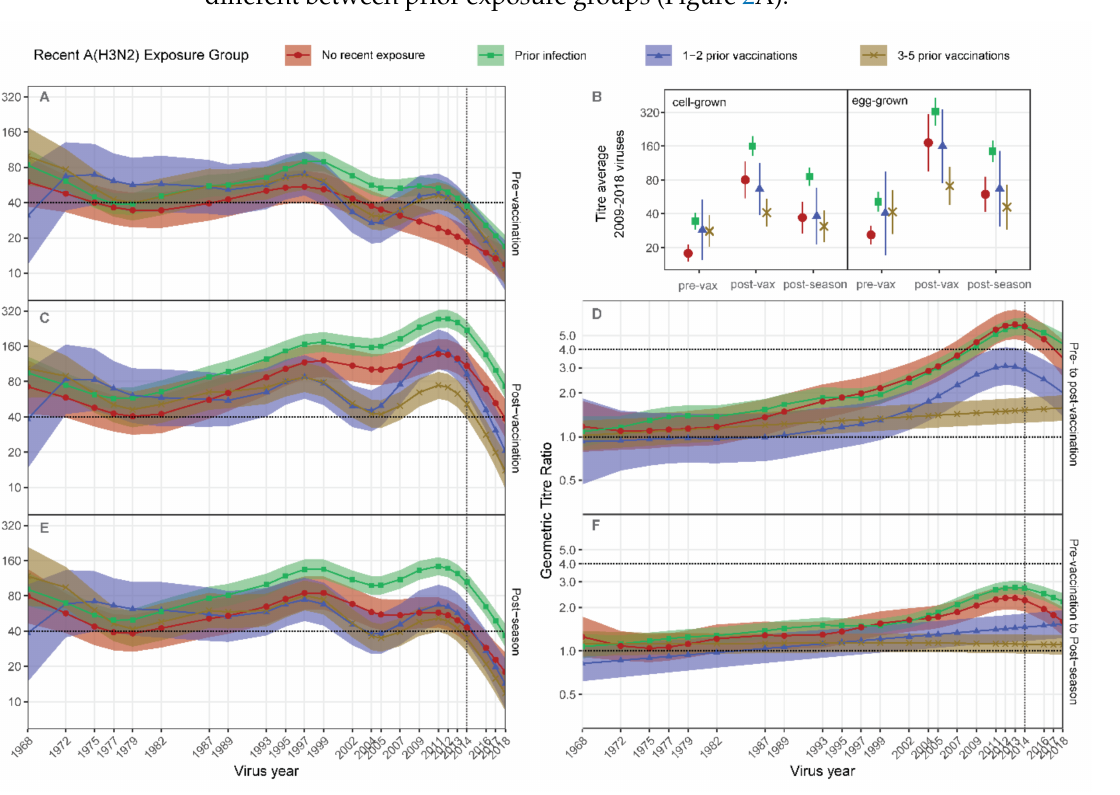
Figure 2. Antibody landscapes induced by vaccination differ between groups defined by prior exposure to A(H3N2). Participants were grouped according to recent prior exposure to A(H3N2) by infection or vaccination (legend), then Generalized Additive Models (GAMs) were used to fit HI titers across 35 viruses. ( A ), Pre-vaccination titer model, ( C ), Post vaccination titer model, ( D ), Pre- to Post-vaccination titer ratio model, ( E ), Post-season titer model, ( F ), Pre-vaccination to Post-season titer ration model. Shading indicates 95% confidence intervals for the models. Numbers/group are presented in Table 2. Dashed vertical lines indicate the vaccine strain. Dashed horizontal lines indicate sero-positive or sero-conversion thresholds. ( B ), titers averaged against 2009 to 2018 viruses that were cell-grown or egg-grown are presented as GMTs for each time-point and prior exposure group. Error bars represent 95% confidence